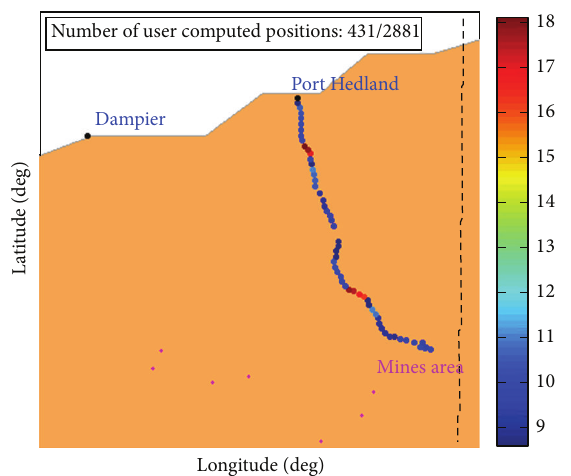
Figure 21: Horizontal accuracy mapping − 24/24 GPS constellation and 4RF interfering satellites.